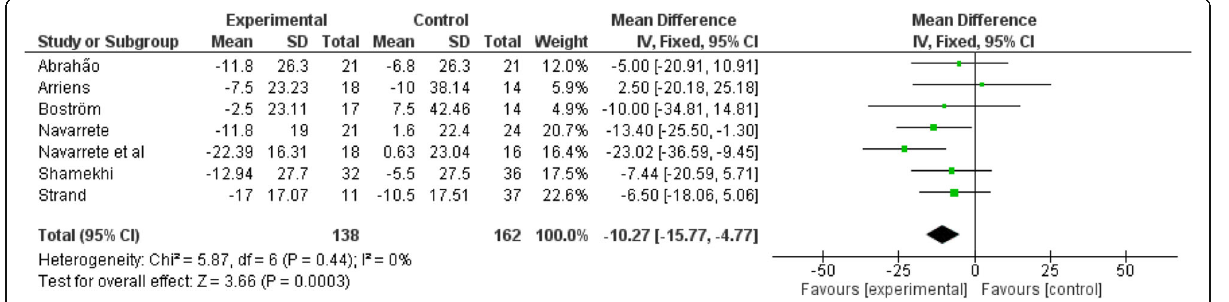
Fig. 3 Forest plot showing the results of the meta-analysis (intervention versus